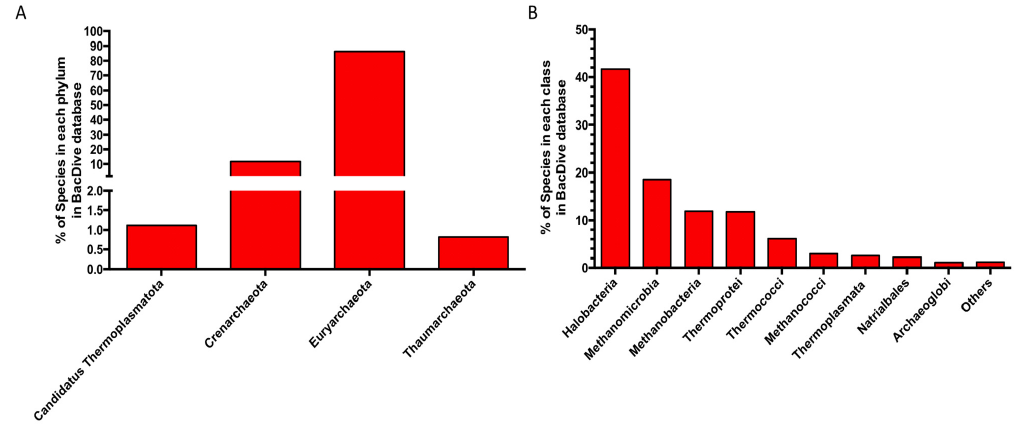
Figure 6. Distribution of the archaeal species in the BacDive metadatabase. ( A ) Phylum level. ( B ) Class level. Others: classes with abundances < 1%.